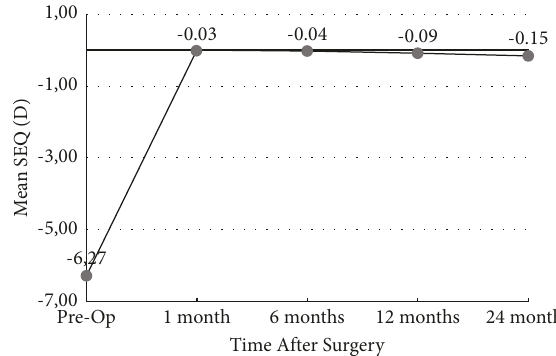
Figure 2: Stability of manifest refraction spherical equivalent over time in SMILE Xtra group ( y -axis: spherical equivalent in diopters; x -axis: postoperative time interval in